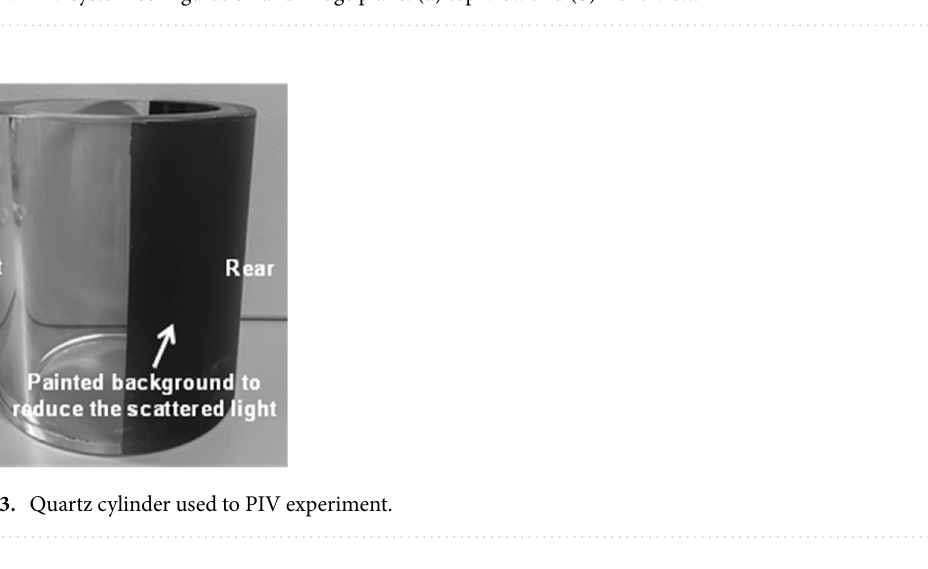
Figure 2. PIV system configuration and image plane: ( a ) top-view and ( b ) front-view.